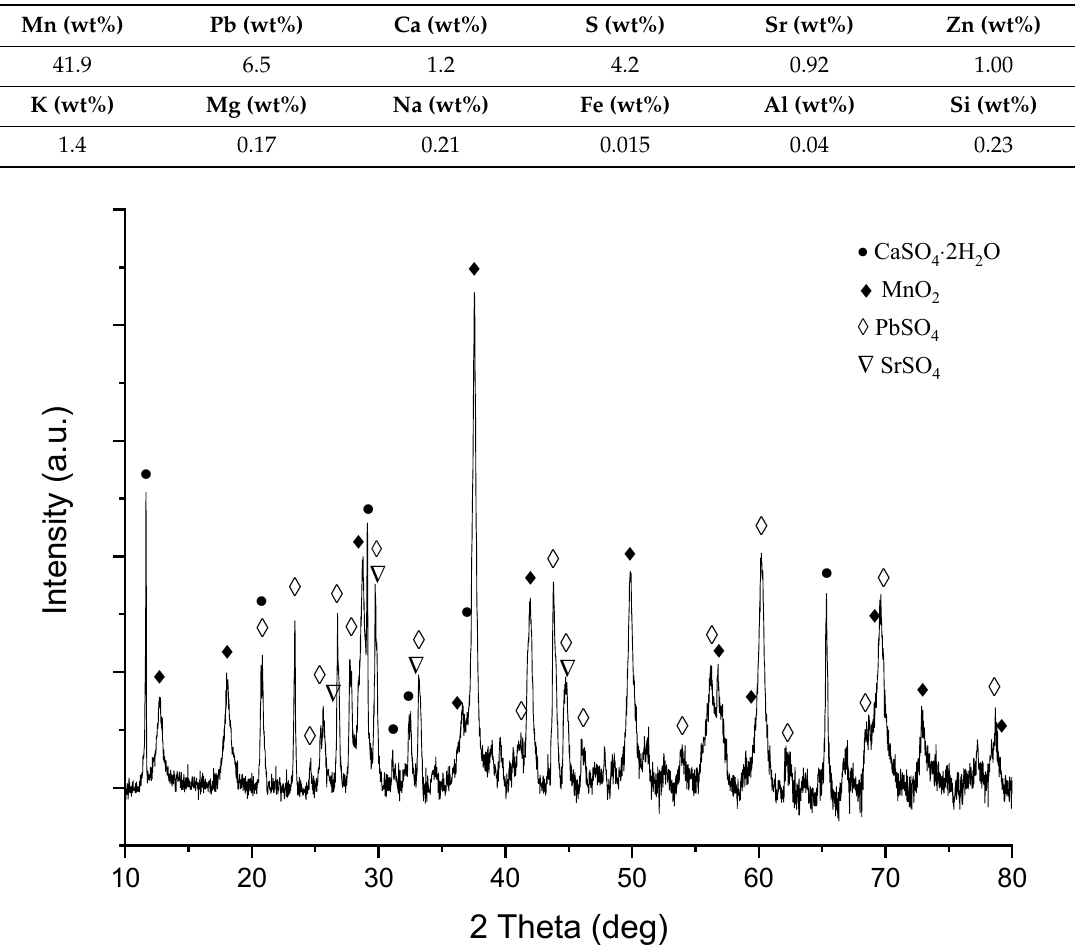
Figure 1. XRD pattern of anode sludge sample.